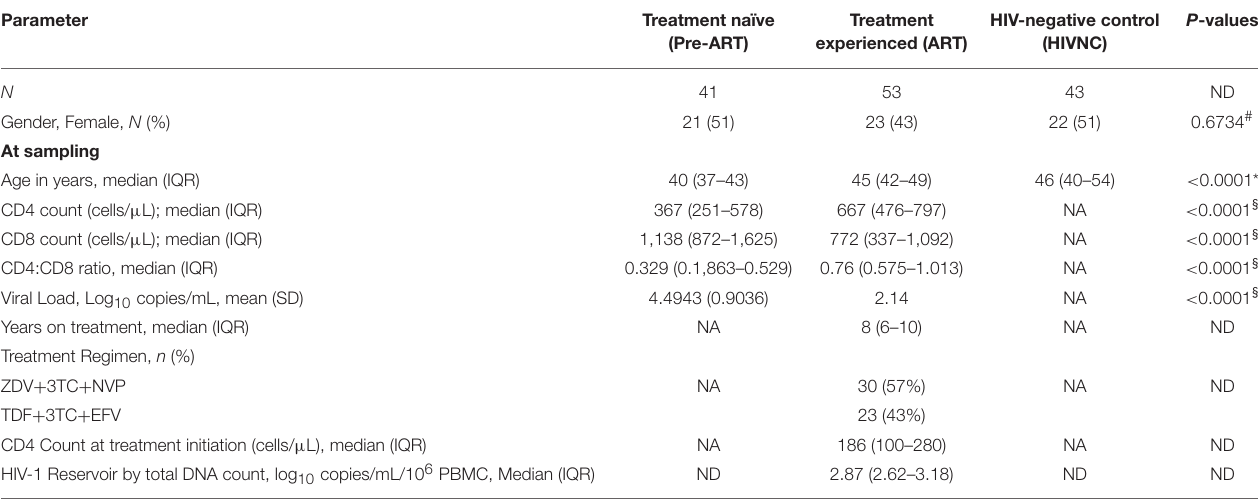
TABLE 1 | Patients’ demographic and clinical parameters. Parameter Treatment naïve